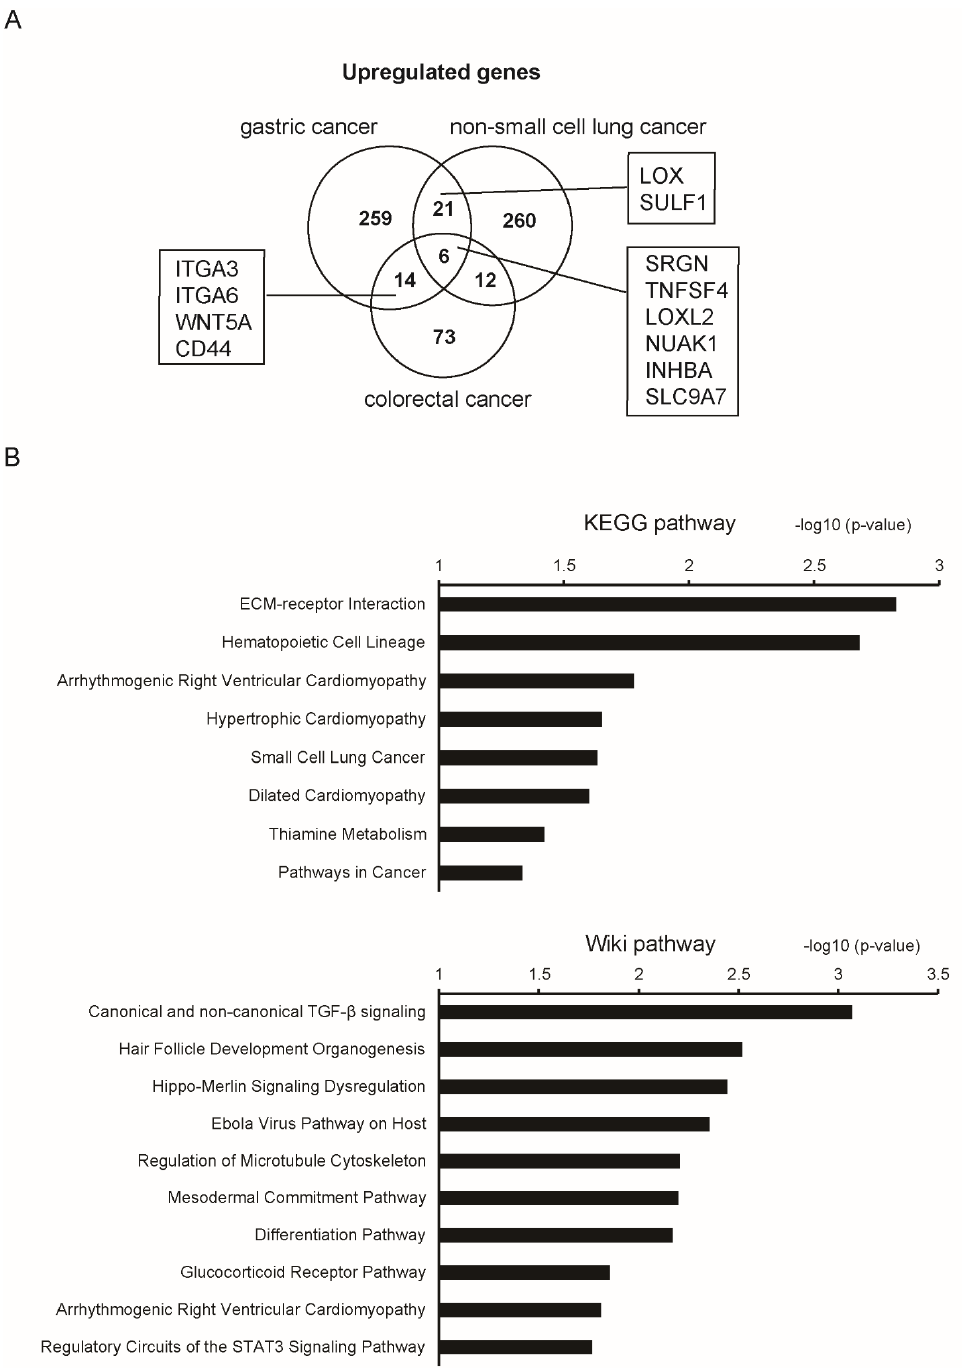
Figure 2. Upregulated genes in CAFs identified in different cancer types. ( A ) Venn diagram showing the genes upregulated in CAFs relative to NFs in colorectal cancer (CRC), gastric cancer and non-small cell lung cancer. The number of identified genes is indicated. Representative overlapping genes are indicated. Upregulated genes in CAFs were identified as follows. CRC: expression profiling data by microarray were obtained from the GSE70468 dataset. Upregulated genes in CAFs relative to their normal counterparts were extracted by the thresholds of a p -value < 0.05 and log fold-change > 1. Gastric cancer: fragments per kilobase of exon per million reads mapped (FPKM) data of 11 matched NFs and CAFs were obtained from the GSE83834 dataset. Deseq2 was performed and the top 300 upregulated genes were extracted. Non-small cell lung cancer: expression profiling data by microarray were obtained from the GSE22874 dataset. Upregulated genes in CAFs relative to NFs were extracted by the thresholds of a p -value < 0.05 and log fold-change > 1. ( B ) Pathway analyses (KEGG and Wiki pathways) were performed using CAF-upregulated genes in at least two cancer